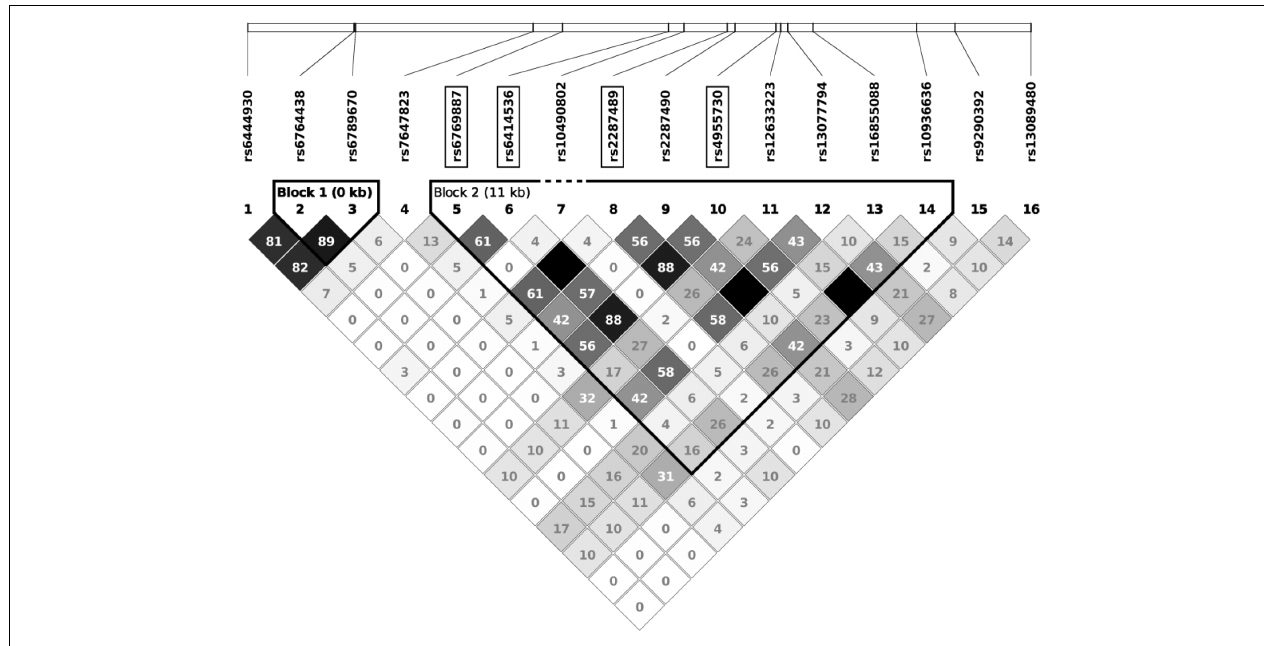
FIGURE 4 | Linkage disequilibrium plot for SNPs located near ( ± 10 kb) rs2287489 and rs6414536 in the VIRSTA cohort. The white horizontal bar (top) illustrates SNPs location on a physical scale. LD values ( r 2 ) are presented in boxes. Strong LD is defined as an r 2 > 0.8 (darkest color). The top four associated SNPs are framed.